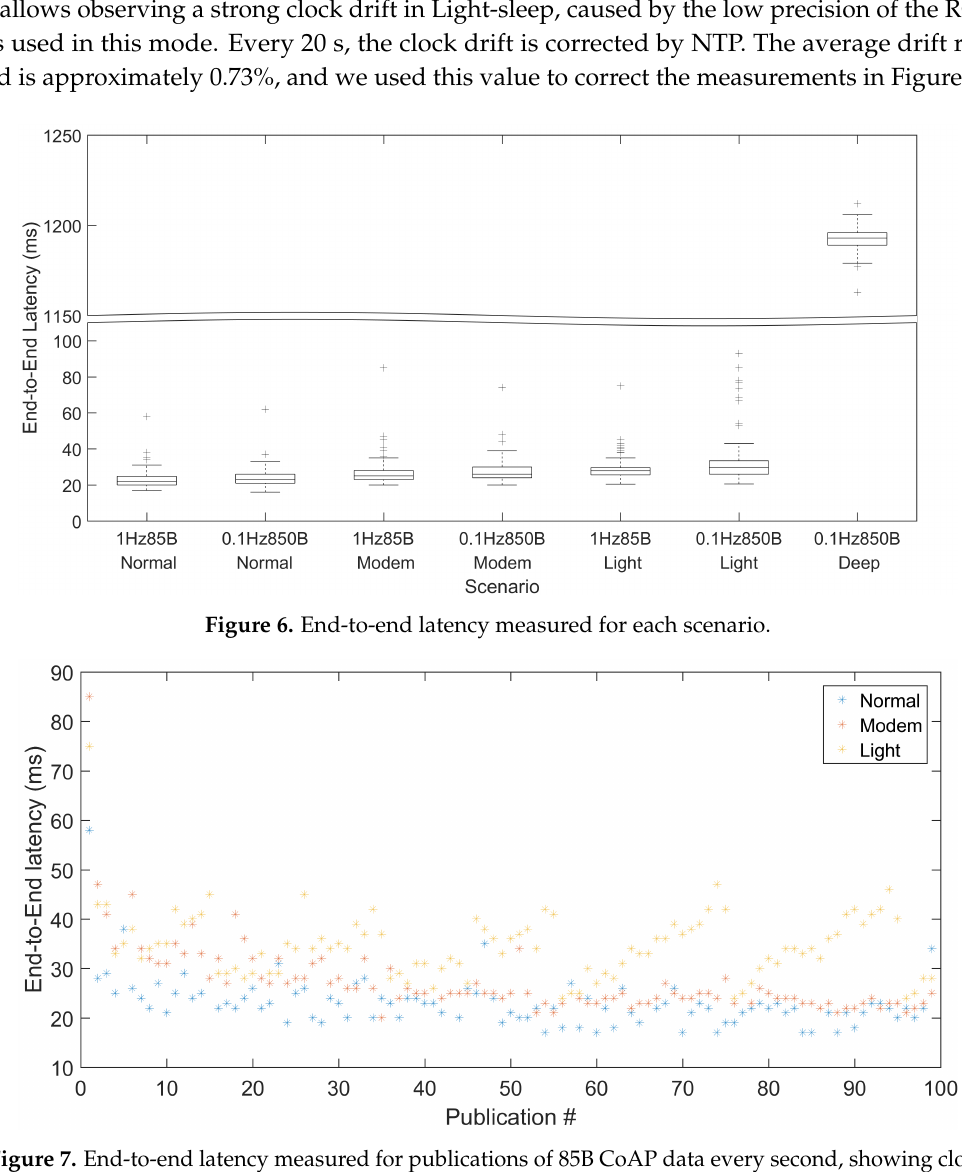
Figure 7. End-to-end latency measured for publications of 85B CoAP data every second, showing clock drift of the Light-sleep